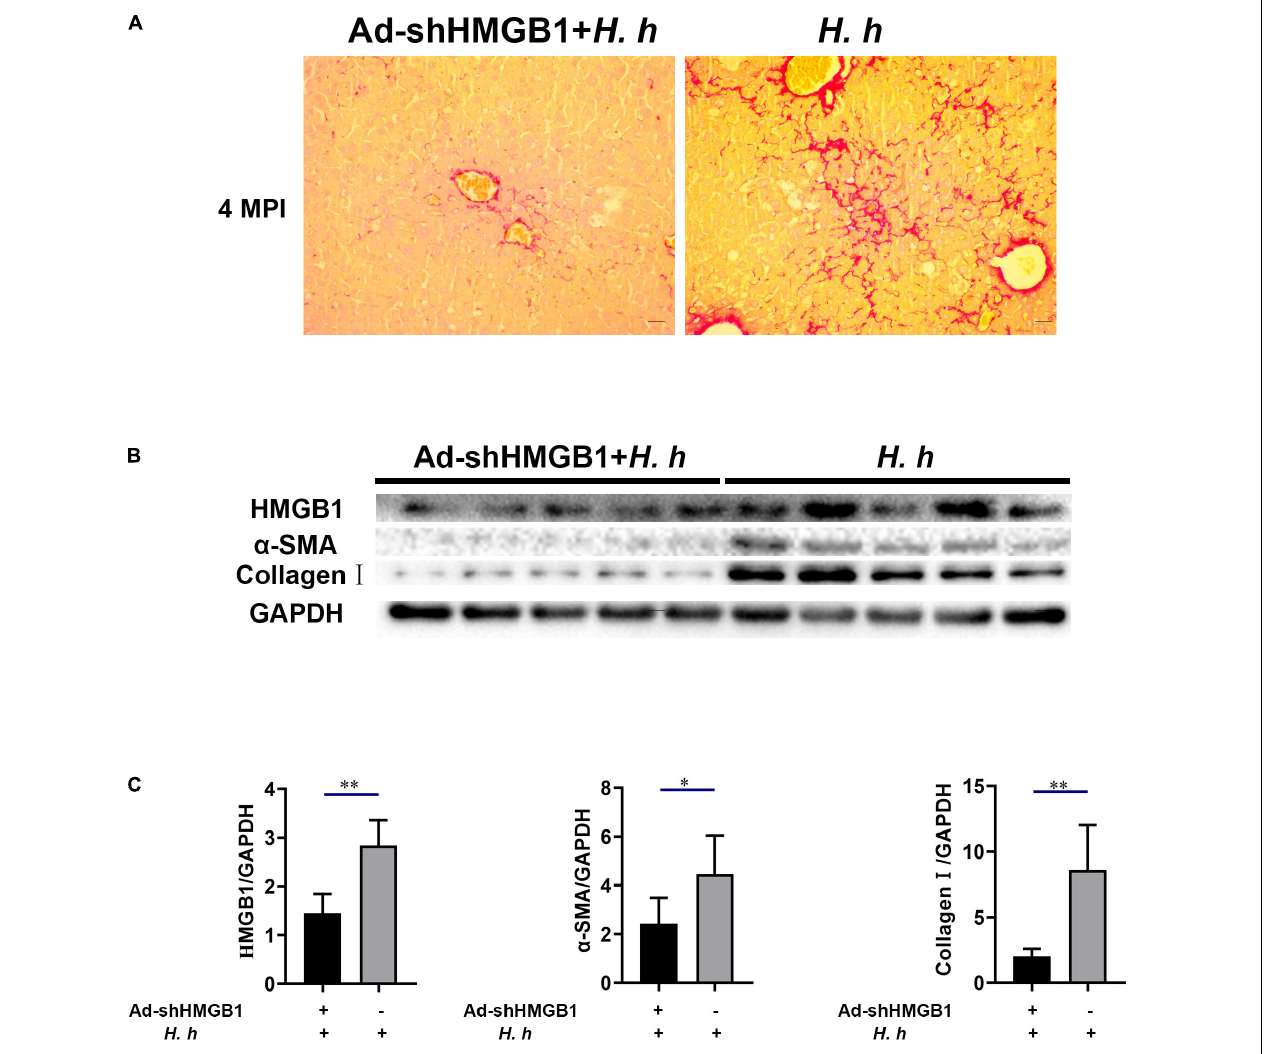
FIGURE 8 | Knockdown of HMGB1 expression could alleviate liver fibrosis in BALB/c mice infected with H. hepaticus at 4 MPI. (A) Sirius red staining of liver sections including AdshHMGB1 + H. h group and H. h group at 4 MPI. (B,C) Western blot and densitometric analysis of hepatic HMGB1, α -SMA, collagen I, and GAPDH of AdshHMGB1 + H. h group and H. h group at 4 MPI. Data are expressed as the means ± SD ( n = 5). ∗ p < 0.05 and ∗∗ p < 0.01 as compared to the control. Each group contained five